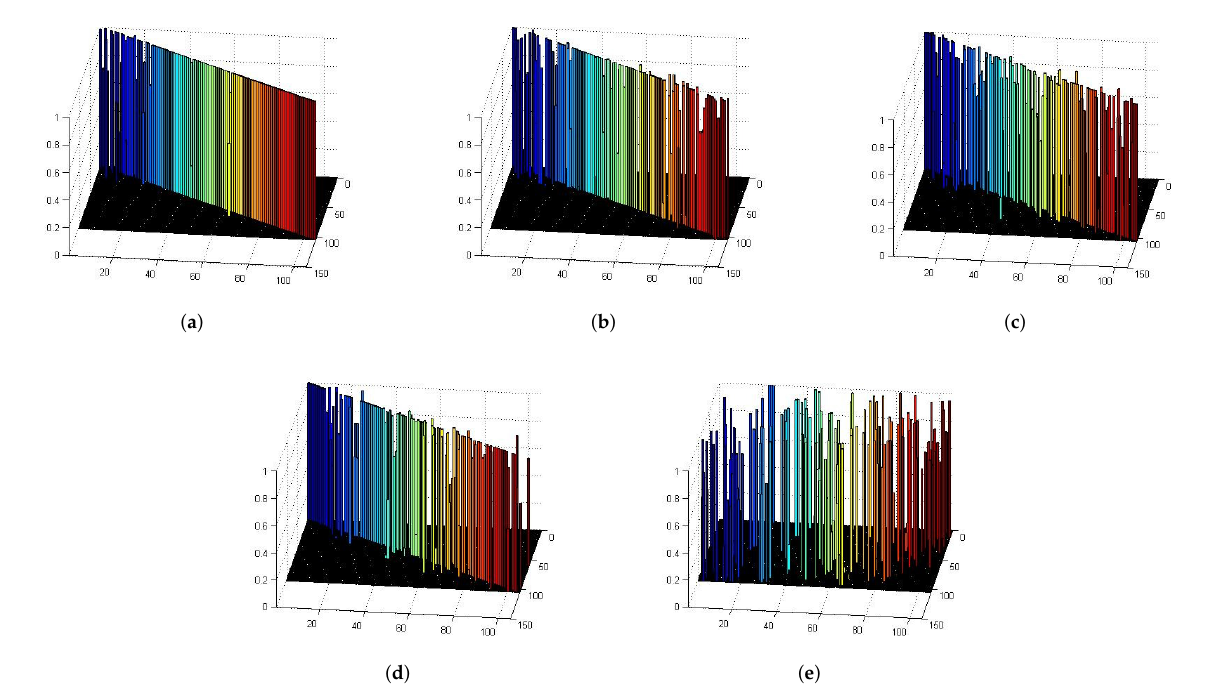
Figure 7. The assignment matrix obtained by MLGM from matching results on the Blessing dataset with different degree of deformation ( a – e